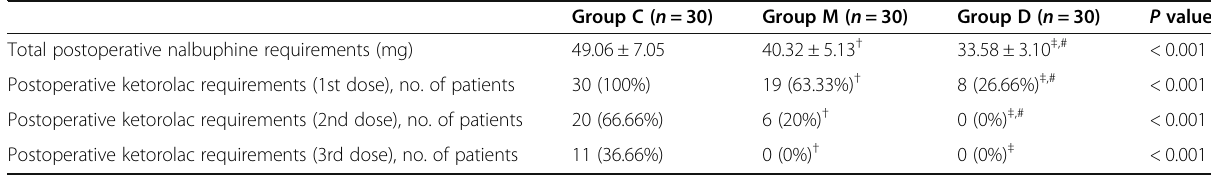
Table 9 Postoperative analgesia requirements expressed as mean ± SD or number of patients